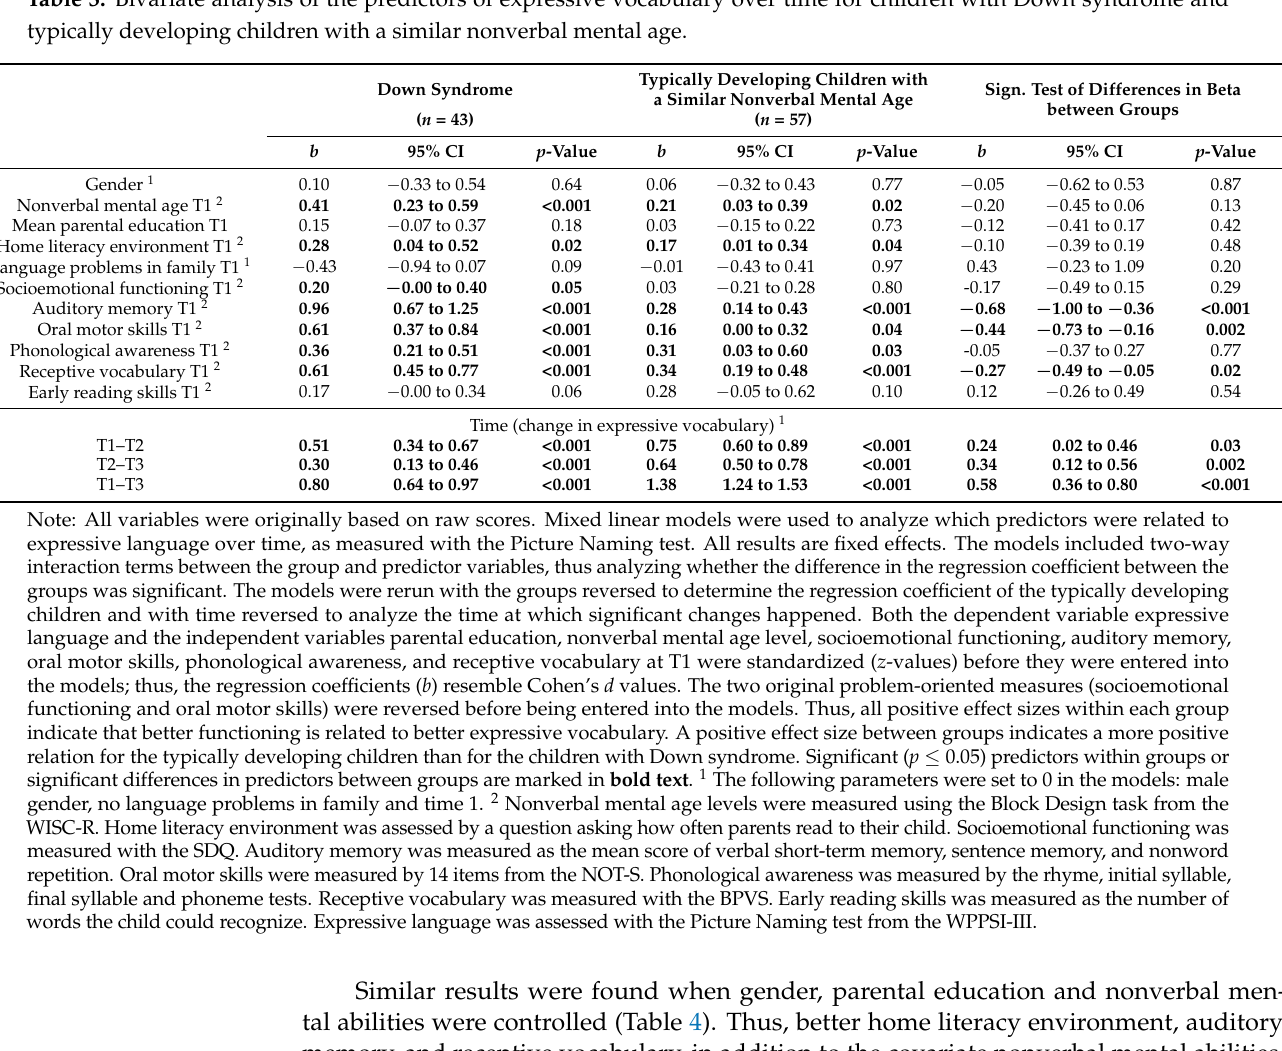
Table 3. Bivariate analysis of the predictors of expressive vocabulary over time for children with Down syndrome and typically developing children with a similar nonverbal mental age.